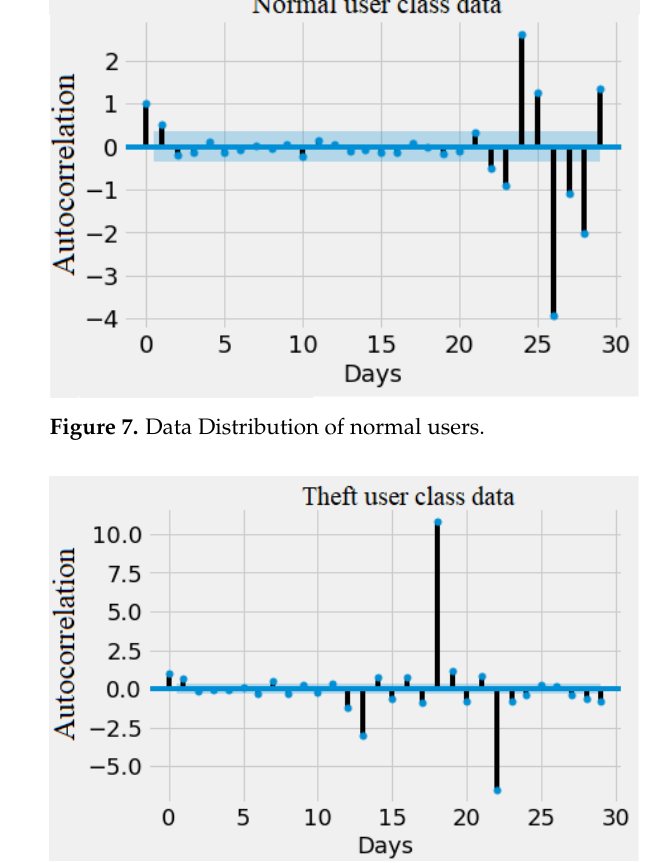
Figure 8. Data distribution of theft users.